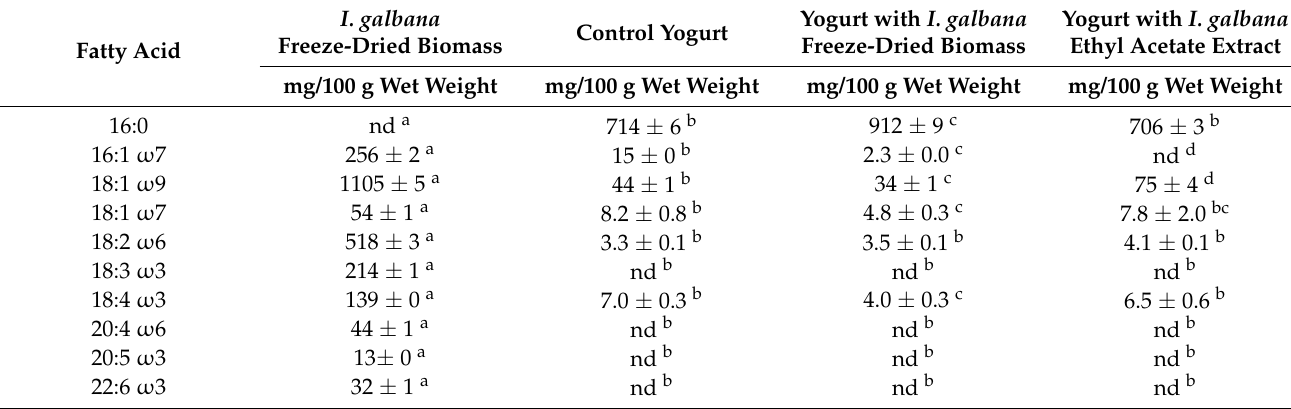
Table 4. Specific bioaccessible fatty acids (mg/100 g wet weight) in I. galbana freeze-dried biomass, control yogurt, yogurt with 2% ( w / w ) of I. galbana freeze-dried biomass and yogurt with 2% ( w / w ) of I. galbana ethyl acetate extract.